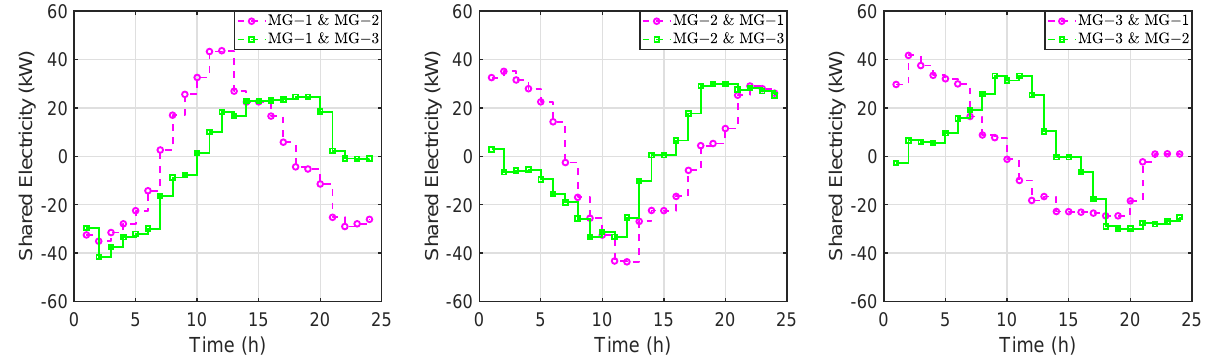
Figure 8. The electricity trading profiles between